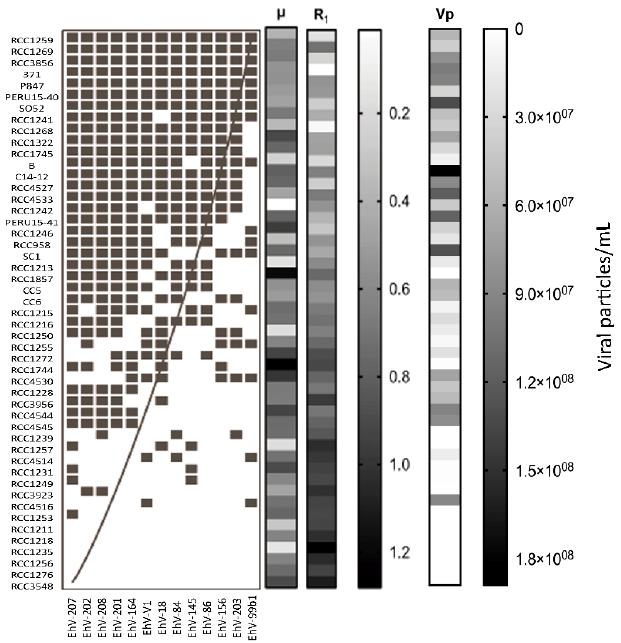
Figure 6. Viral ‐ host infectivity network with a clear nested pattern (NODF value of 0.60) where specialist viruses tend to infect the most susceptible hosts, while viruses with broader host ‐ range infect hosts with higher resistance. ■ : infection; □ : no infection. Sidebars represent µ , R 1 and Vp parameters, respectively.